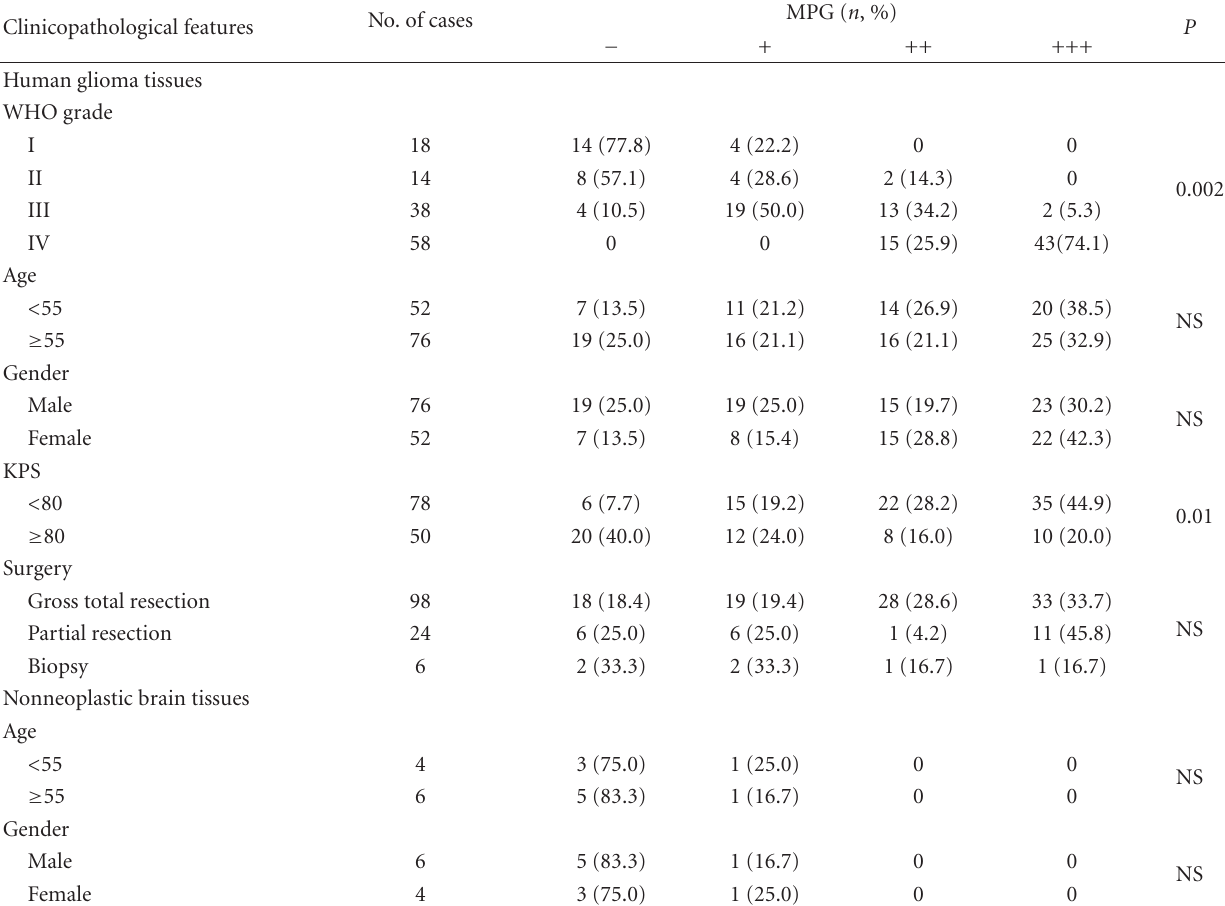
Table 1: MPG expression in human glioma and nonneoplastic brain tissues with di ff erent clinical-pathological features. Clinicopathological features Human glioma